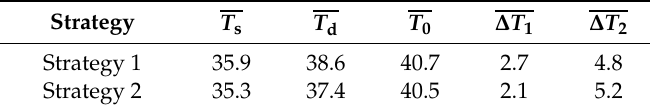
Table 9. Comparison of cooling e ff ect between Strategy 1 and Strategy 2.